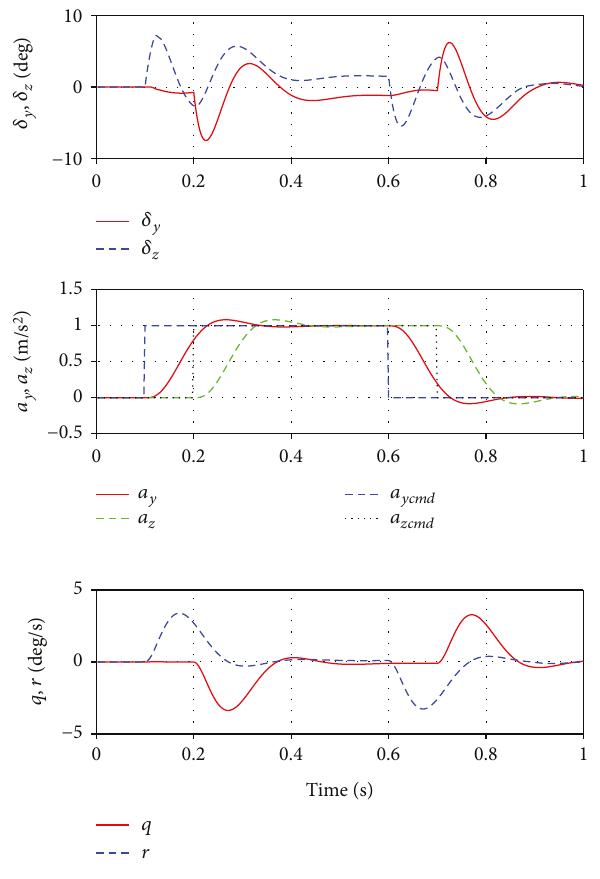
Figure 9: Control performance with Λ = 0 9 I .